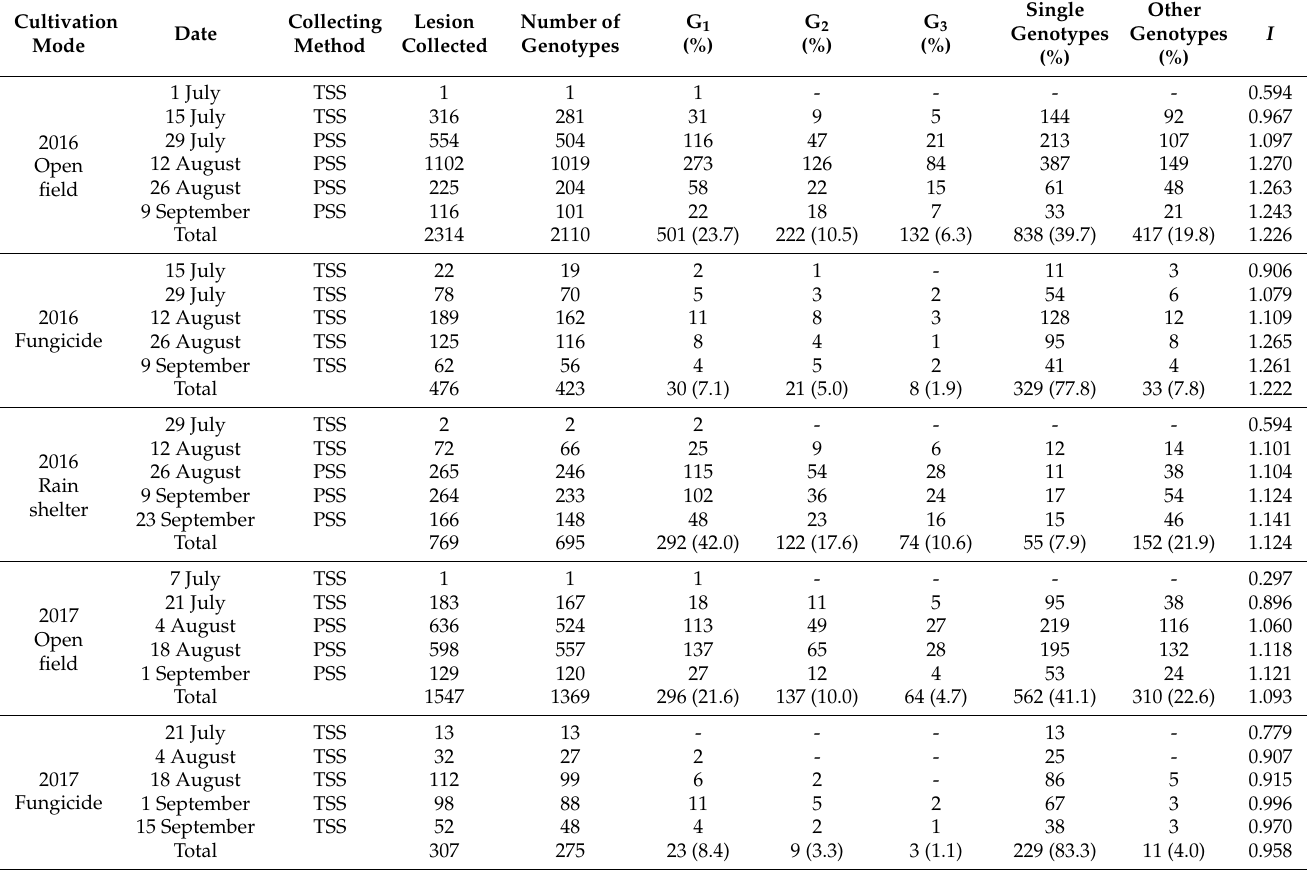
Table 3. Sampling, lesions collected and analyzed, and number and temporal dynamic of Plasmopara viticola genotypes in open-field, fungicide-managed and rain-shelter cultivations during the period